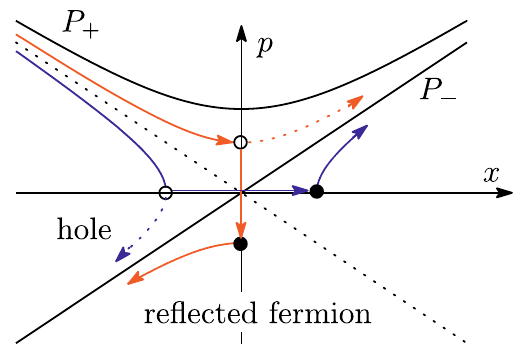
Fig. 5 The mechanism of the appearance of the Hawking radiation in the acoustic black hole (right) in the phase space. The holes and the reflected fermions which are not allowed in the classical motions cause the acoustic Hawking radiation when we consider the quantum